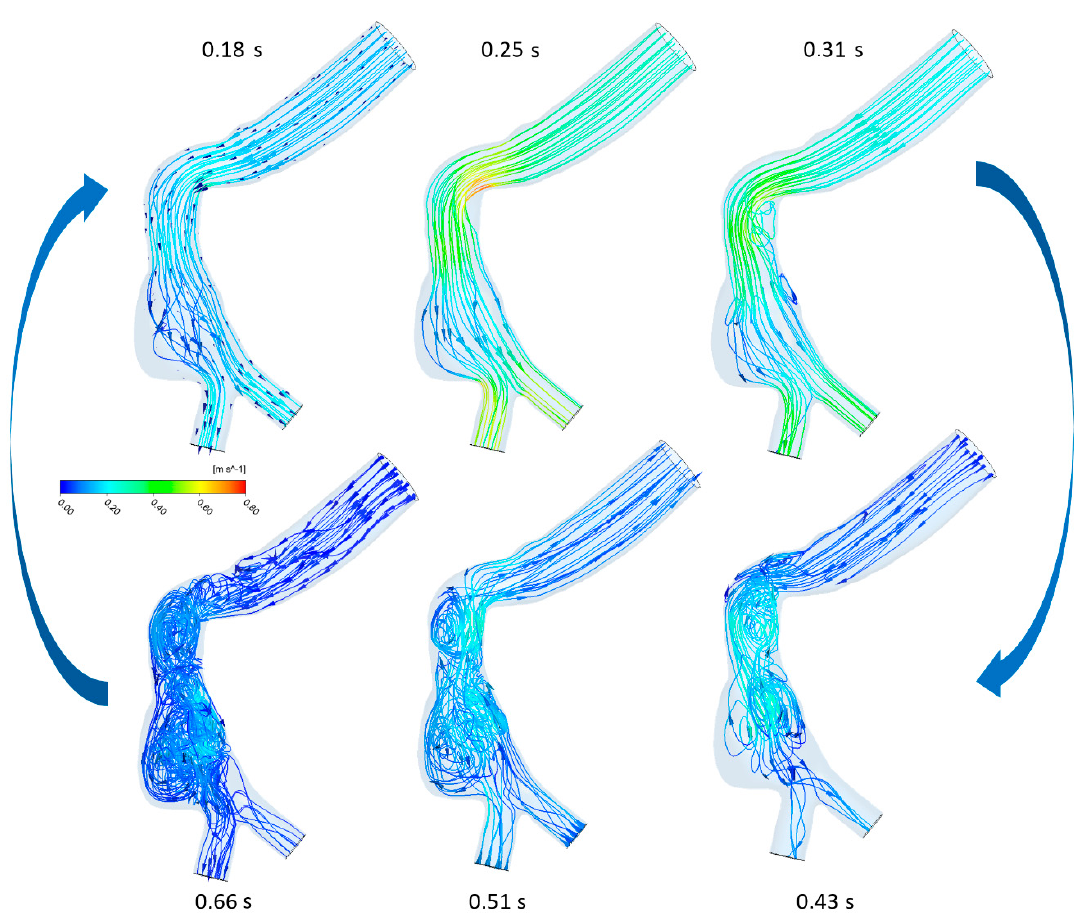
Figure 6. 3D streamlines at the selected instants of the cardiac cycle.